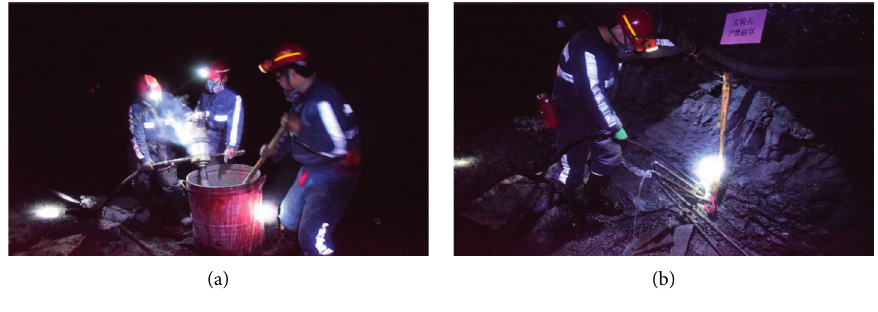
Figure 14: Sealing-grouting